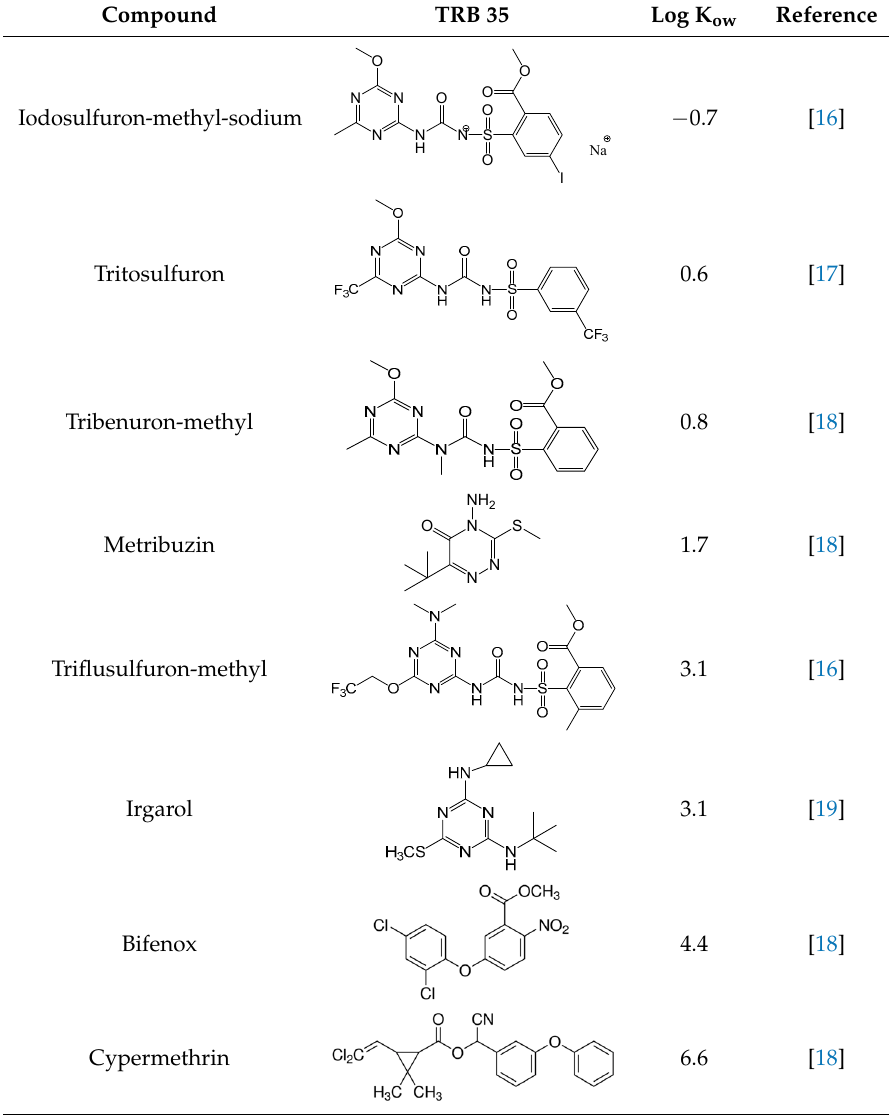
Table 1. Chemical structures of the tested compounds and their respective log K ow (values taken from the literature).